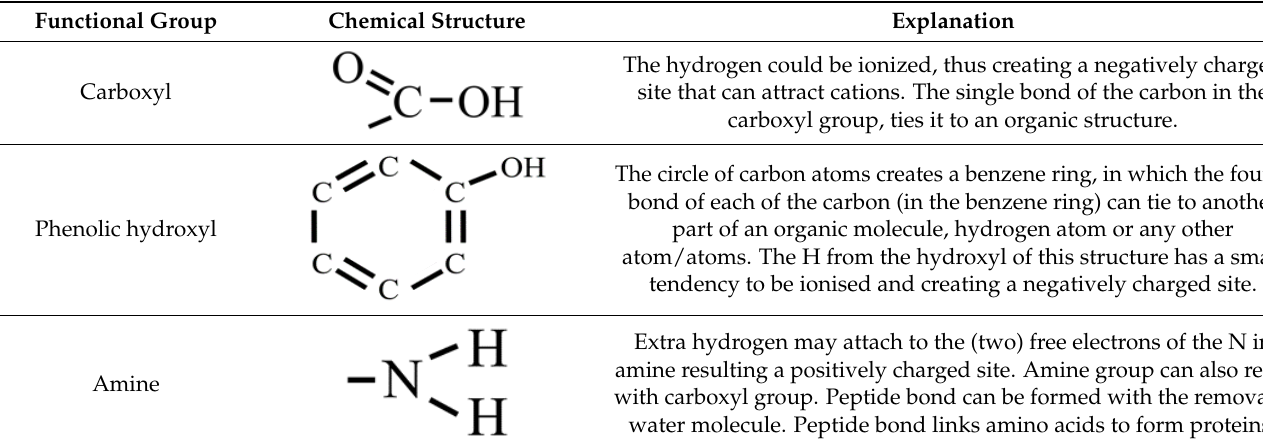
Table 2. Chemical structures of the functional groups of the humic substances (adapted from Troeh and Thompson [67]). Functional Group